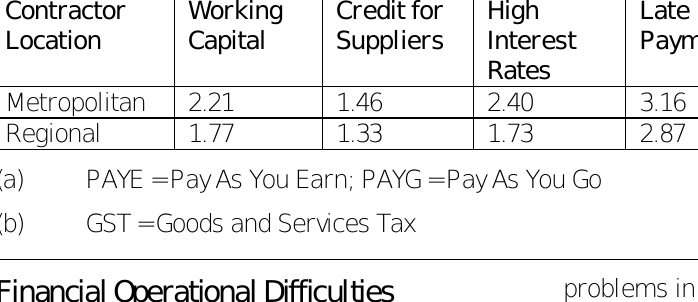
Table 2: Mean Likert Values for Operational Characteristics Contractor